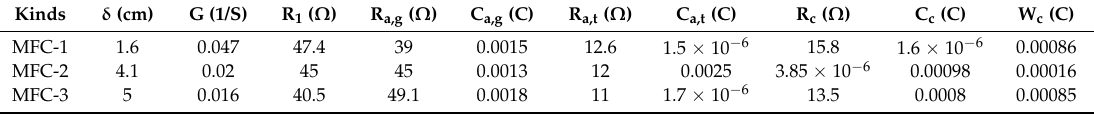
Figure 1. The voltage output versus time of microbial fuel cells (MFCs) with different hydrodynamic boundary layer thicknesses. Table 1. Internal resistance of MFCs with respect to hydrodynamic boundary layer